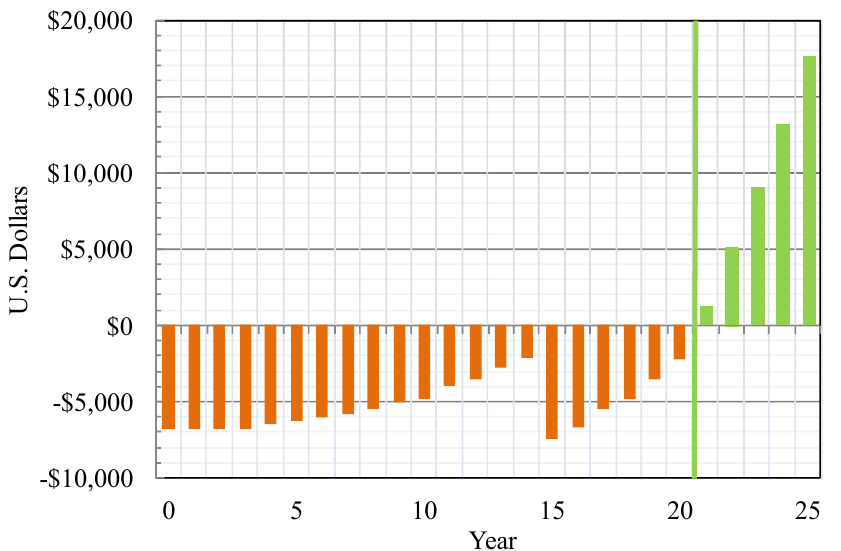
Figure 12. Cumulative cash